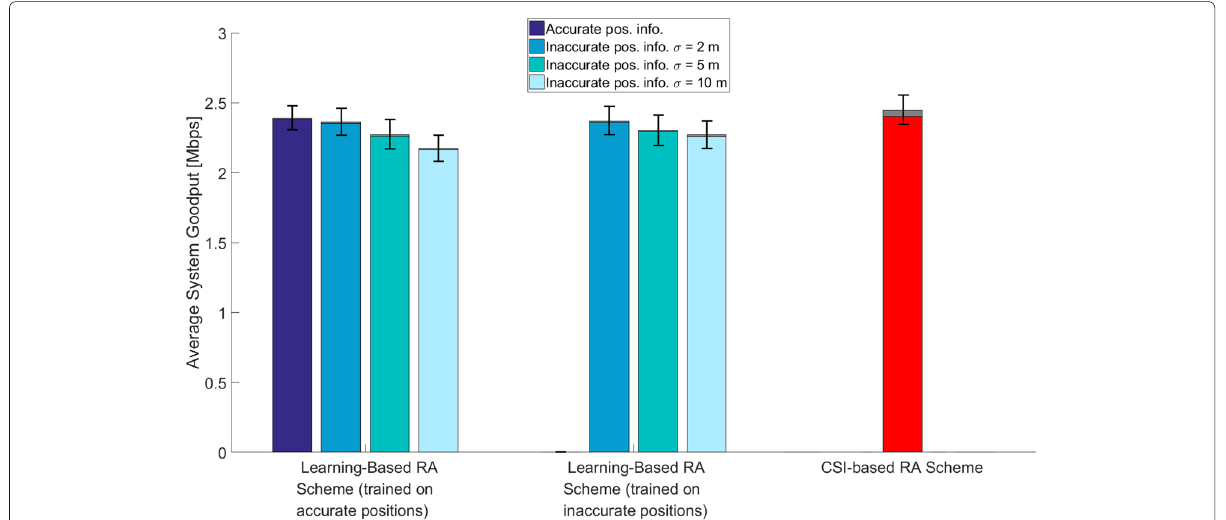
Fig. 6 Average system goodput for different schemes and various possibilities of available position